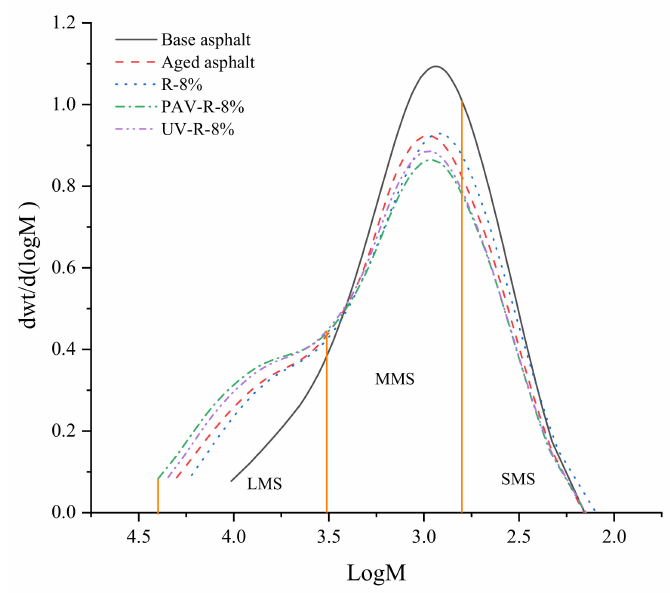
Figure 14. Molecular weight distribution of different asphalts.